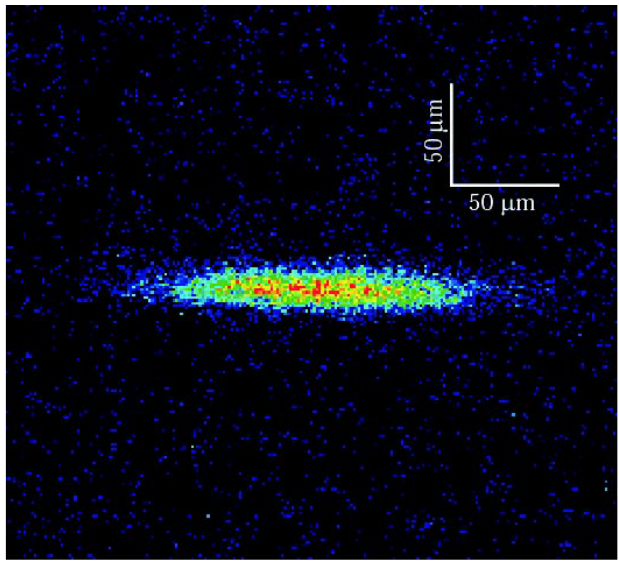
FIG. 10. (Color) Typical beam image obtained by the FZP monitor after the background was subtracted. Beam current was a 4.4 mA in a single-bunch mode. The shutter opening time was fixed to 1 ms. The horizontal and vertical bars of 50 (cid:1) m show the scales at the source